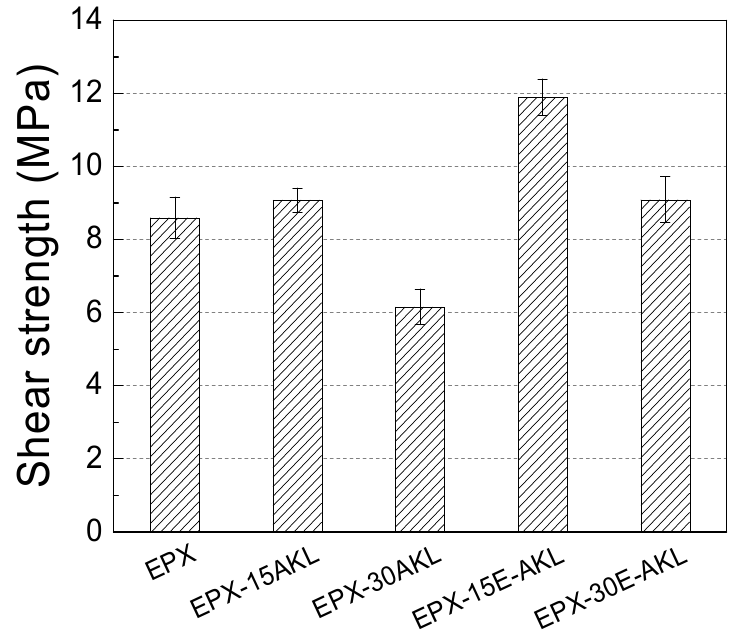
Figure 10. Single lap shear strength of the neat epoxy, nonmodified lignin-based epoxy, and epoxidized lignin-based epoxy in steel substrate.